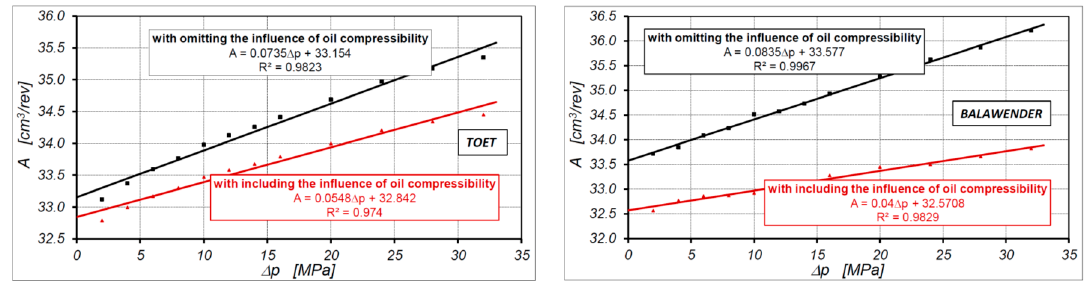
Figure 15. Characteristics of working volume A vs. pressure drop ∆ p in the motor. On the left—Toet’s method; on the right—Balawender’s